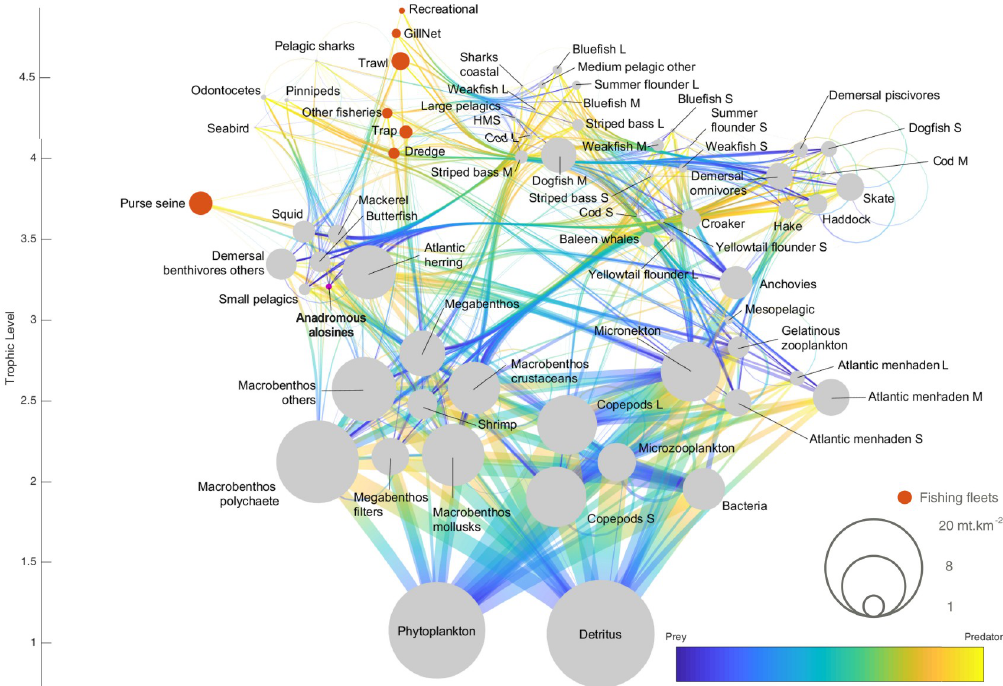
Fig 2. Flow diagram of the Contemporary Alosine Biomass model. The color gradient represents the direction of flow; different life stages are represented by small (S), medium (M) and Large (L). Functional groups are ordered by trophic level. Grey bubbles represent all functional groups, the pink bubble in bold letters represents anadromous alosine, and orange bubbles represent fishing fleets.